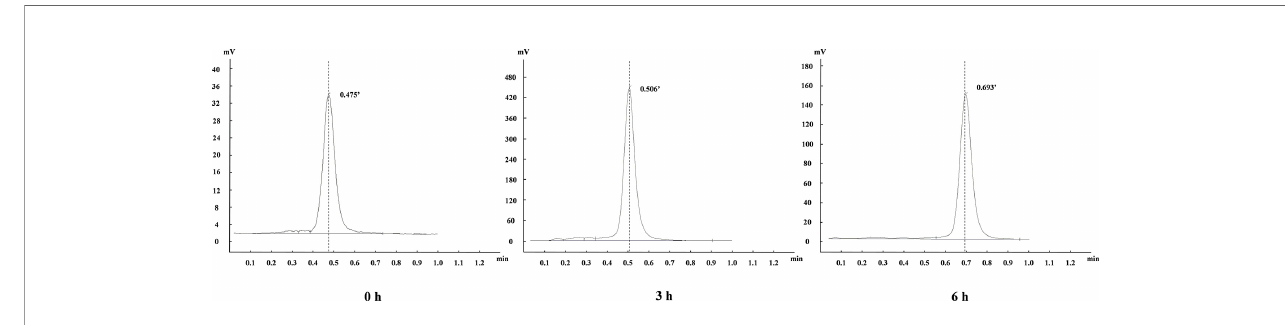
FIGURE 3 | Radiochemical purities determined by iTLC-SG at 0, 3 and 6 h.